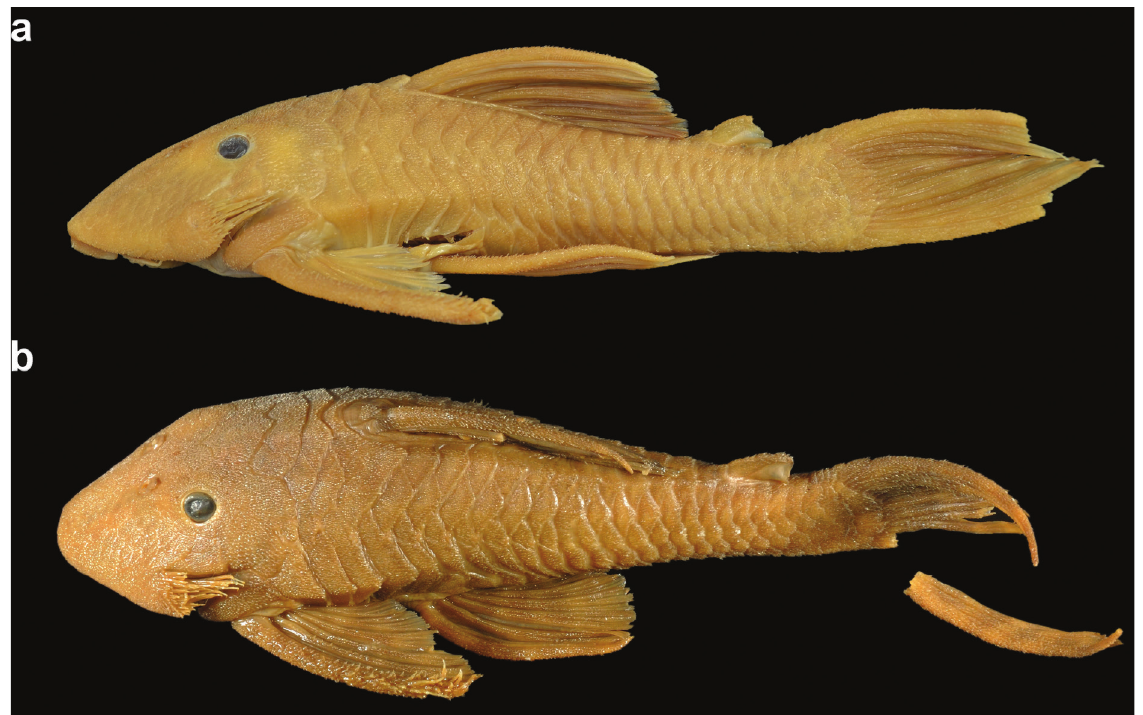
Fig. 3. Lateral views of the topotypes of Panaqolus purusiensis collected by Krukoff: a) USNM 94665, 110.6 mm SL; b) MSNM Pi43, 126.4 mm SL. Photo by G. Bardelli.